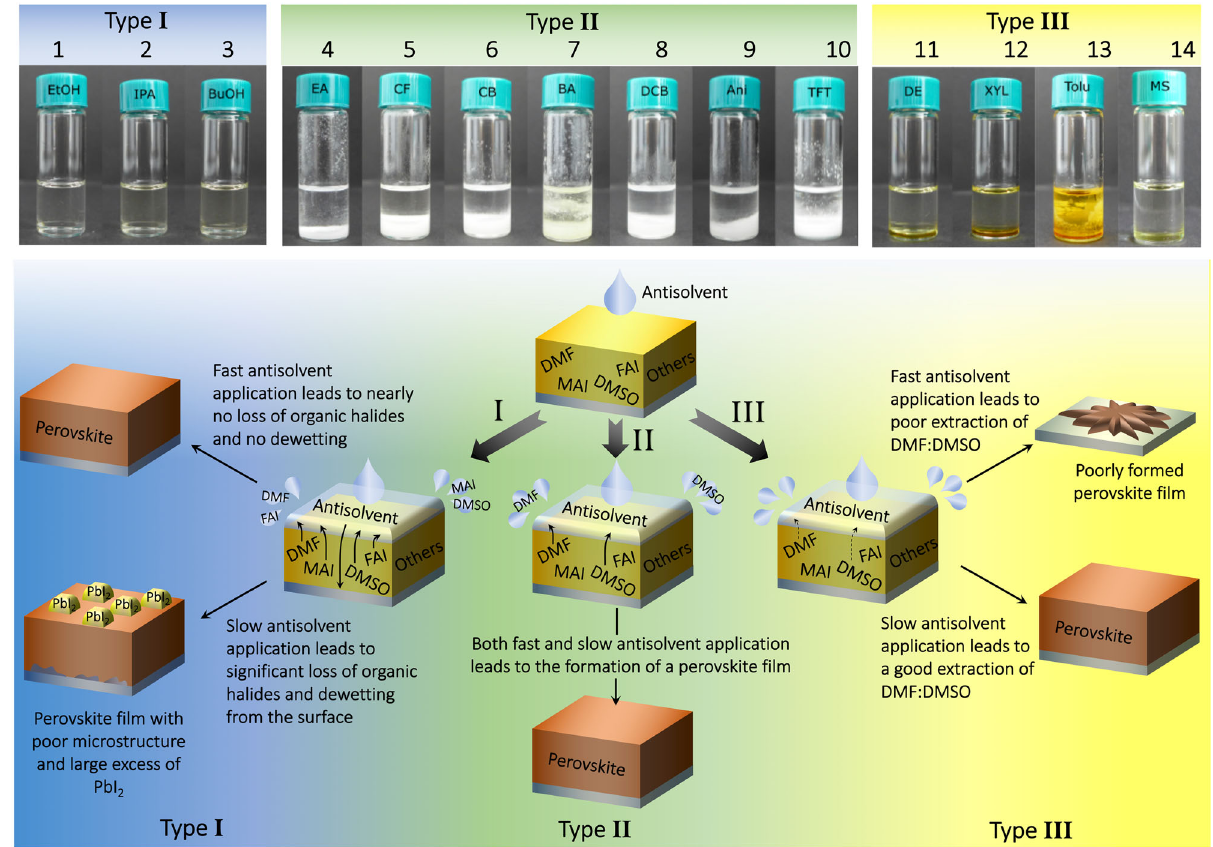
Fig. 6 Summary of the processes taking place during perovskite fi lm formation for the three antisolvent types. Top: solubility of MAI in a solution of DMF:DMSO:antisolvent, meant to simulate the perovskite fi lm intermediate phase during the antisolvent step of fabrication. Bottom: summary of the various mechanisms involved in perovskite fi lm formation by the different categories of